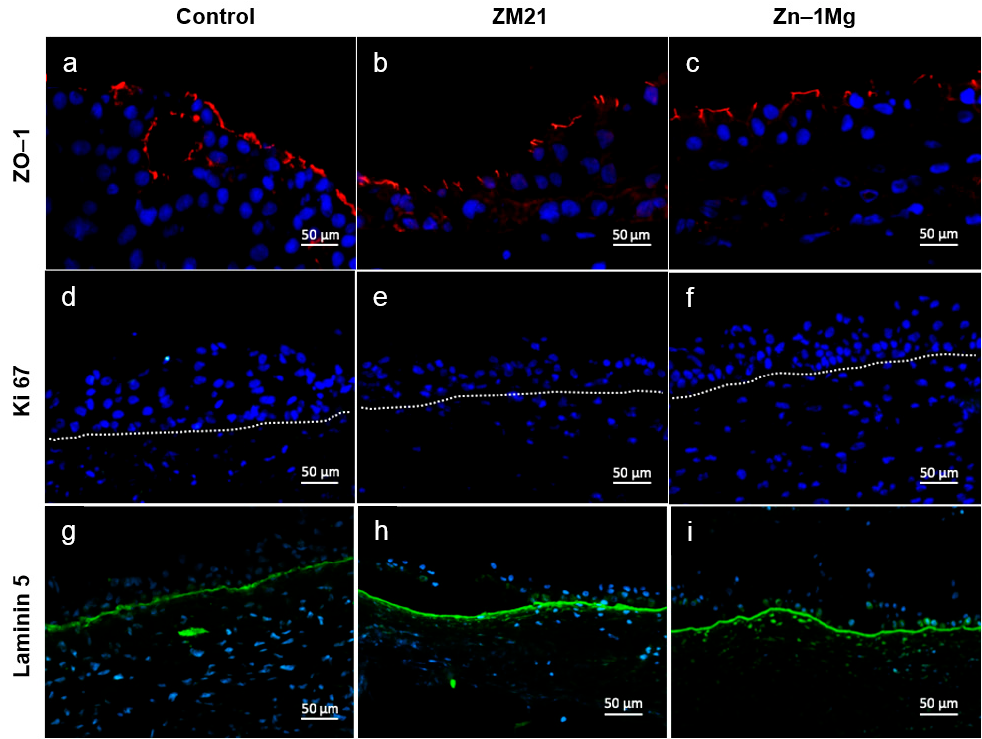
Figure 5. Expression of urothelial differentiation ‐ associated protein and basal lamina in response to contact with metal disk after 7 days of incubation: ( a – c ) immunofluorescence anti ‐ ZO ‐ 1 (red), ( d – f ) Ki67 (green), and ( g – i ) anti ‐ laminin ‐ 5 (green). Nuclei were stained with Hoechst (blue). Tight junctions (TJ) between umbrella cells represent the main permeability barrier in combination with another protein, uroplakins [54]. TJs restrict paracellular diffusion and movement, proteins and lipids between membrane compartments. TJs are composed of cytoplasmic proteins, such as ZO ‐ 1, linking TJs to the cytoskeleton, and integral transmembrane proteins, such as occludin, junctional adhesion molecule, and claudins [55–57].